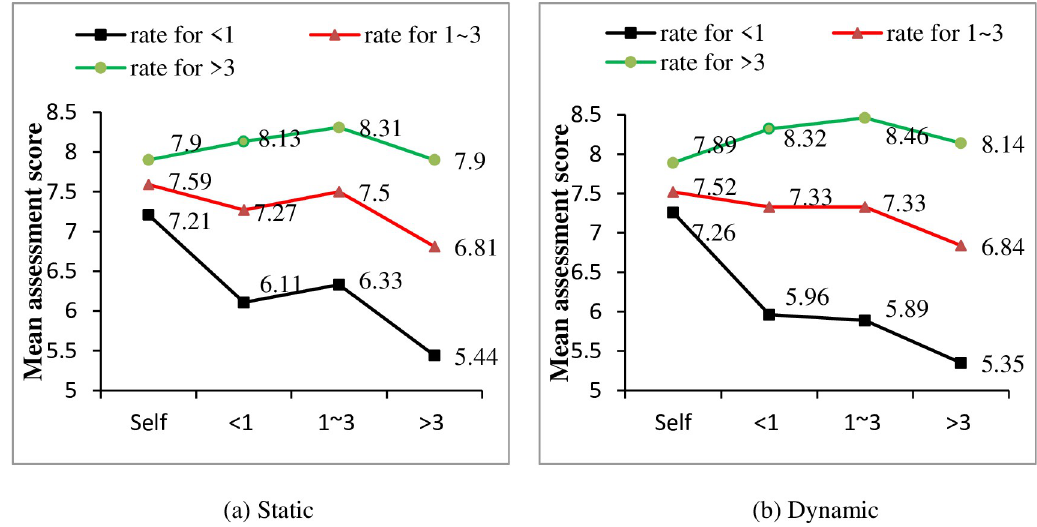
Fig 9. Comparison between self-assessment and mutual-assessment.